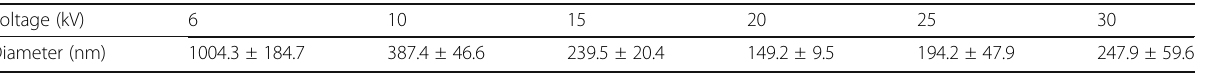
Table 1 The average diameter of PVDF-HFP nanofiber under various voltage value Voltage (kV)